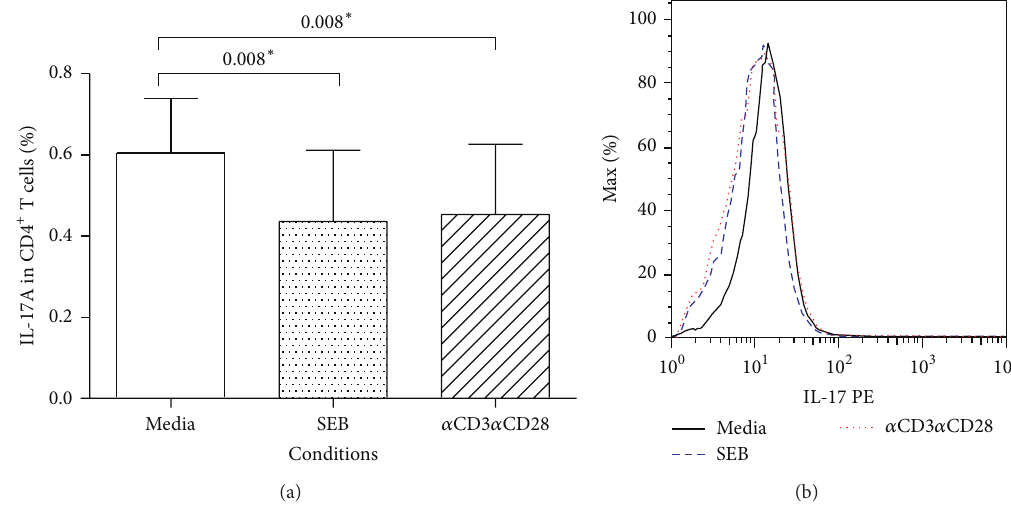
Figure 2: IL-17A expression by CD4 + T cells from HSCT patients with cGVHD following culture with SEB and 𝛼 CD3 𝛼 CD28. Whole blood from HSCT patients with cGVHD was maintained in culture without stimulus (media), as well as with SEB and 𝛼 CD3 𝛼 CD28. IL-17A (a) expression in CD4 + T cells. The ∗ indicates a 𝑃 value < 0.05 between media and stimulus conditions using Wilcoxon’s matched pairs test. The overlap histogram graphics represent IL-17 (b) expression in CD4 + T